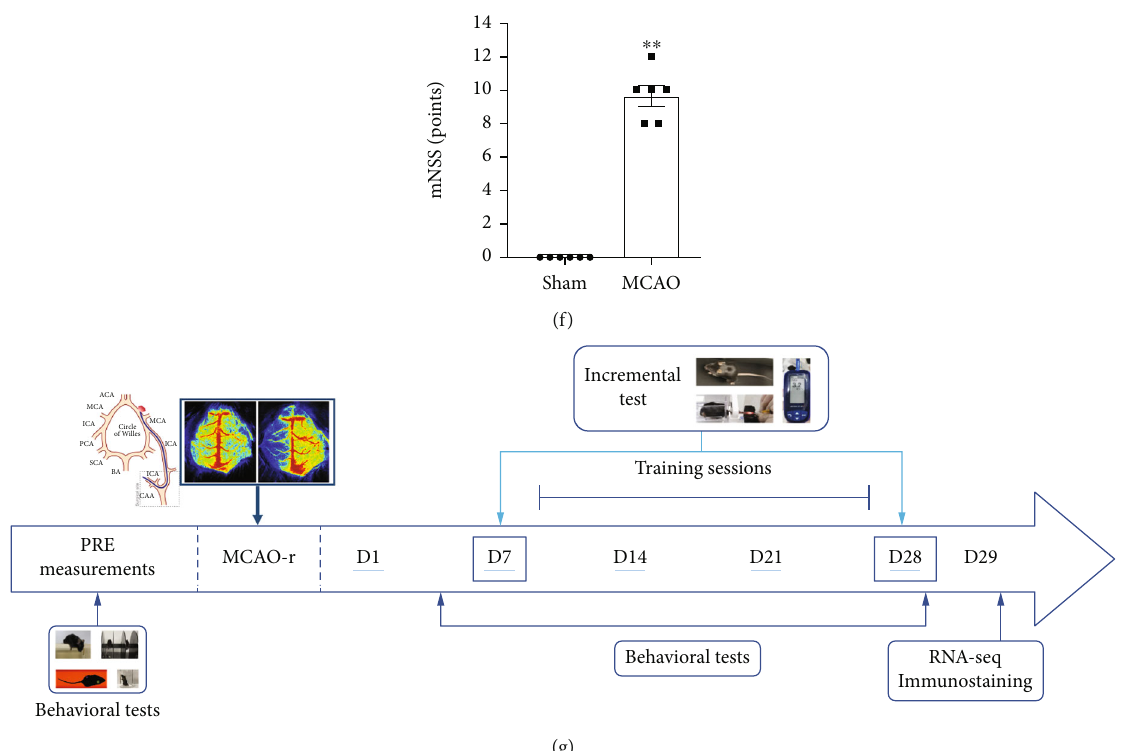
Figure 1: Establishment of the animal model of cerebral ischemia. (a) Middle cerebral artery occlusion (MCAO) was established under cerebral blood fl ow monitored by laser speckle blood fl ow meter. (b) Pseudocolor picture of cerebral blood fl ow before, during, and after MCAO. (c) Triphenyl tetrazolium chloride (TTC) staining showed the infarct size after cerebral ischemia reperfusion. (d) Quanti fi cation of cerebral infarct volume of the ipsilateral brain between sham and MCAO groups ( n = 6 ). (e) Quanti fi cation of cerebral blood fl ow in the ipsilateral hemisphere normalized to the contralateral hemisphere. (f) Modi fi ed neurological severity score (mNSS) of the sham- operated and ischemic mice ( n = 6 ). (g) Experimental design of the study. Mice were subjected to MCAO after baseline assessments. Then, animals were randomly subdivided into sham, sedentary MCAO, moderate-intensity aerobic training (MOD), and high-intensity interval training (HIIT) groups 1 week after MCAO. Following 3 weeks of isocaloric training sessions (MOD and HIIT) or sedentarism (sham and MCAO), all groups underwent posttraining assessments. Values are expressed as the mean ± SEM of the mean. ∗ P < 0 : 05 and ∗∗ P < 0 : 01 as determined by unpaired t